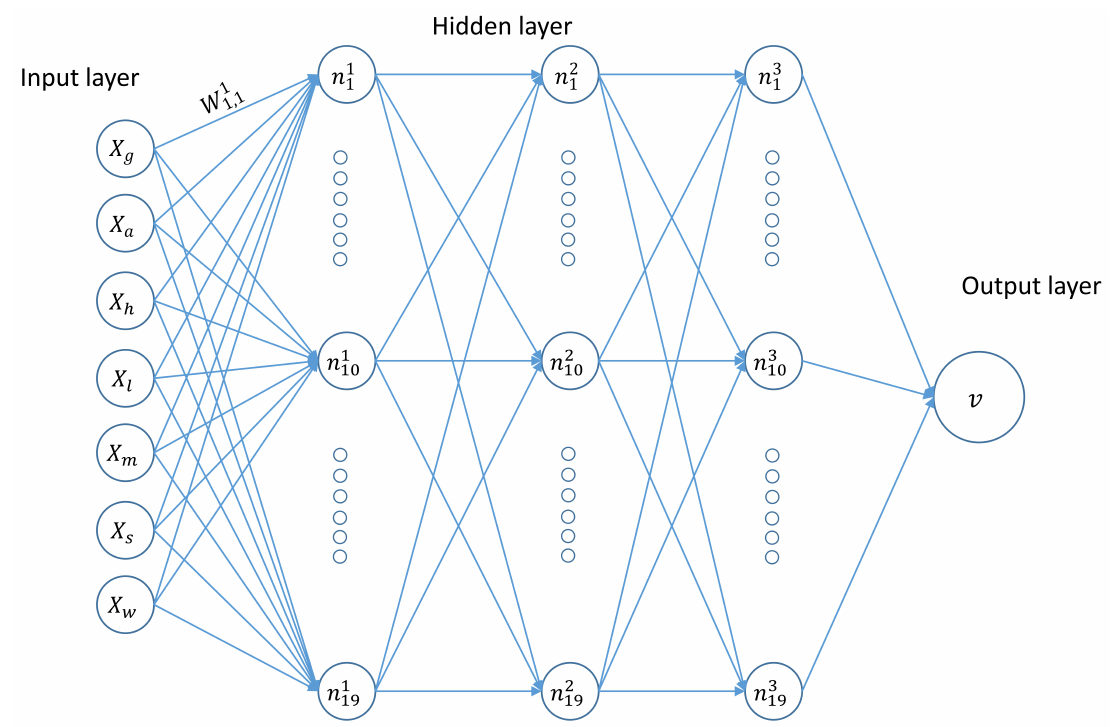
Fig. 9. Structure of the network, X g , X a , X h , X l , X m , X s , and X w denote the input variables, which are gender, age, height, leg length, MRSI, squatting times, and body weight, respectively. The output variable V is VO 2 max. Terms n 1 1 , n 2 1 , and n 3 1 are respectively the first node in the first, second, and third layer, W 1 1 , 1 denotes the weight value from the first node in layer 0 to the first node in layer 2.